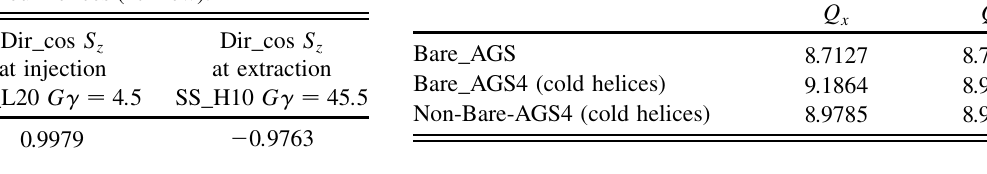
TABLE I. Thevaluesofthedirectionalcosinesofthestablespin direction with the vertical, at the injection point (2nd column) and extractionpoint(3rdcolumn),forthecasesoftwohelices(2ndand 3rd rows) and the case of four helices (4th row).